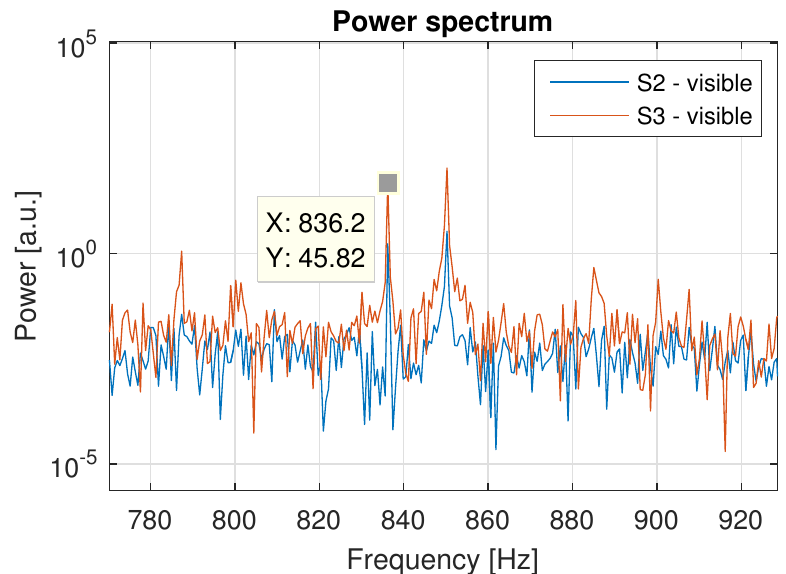
Figure 18. Highest combustion instability at 836 Hz detected by the optical probes in both the primary and secondary